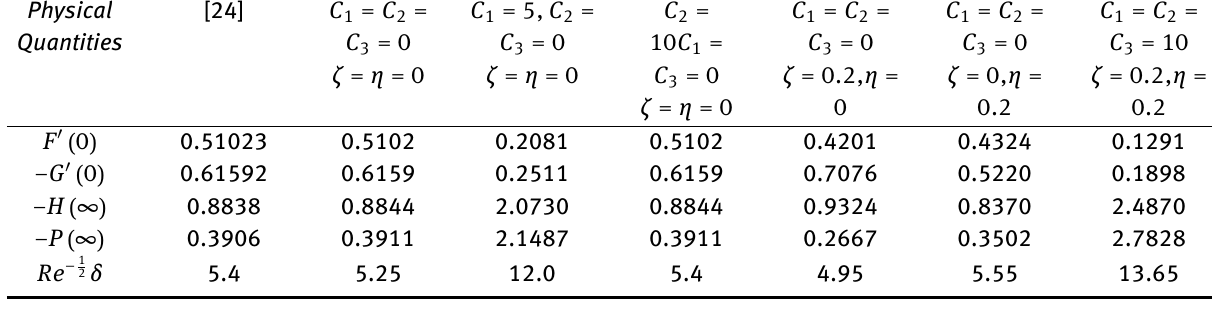
Table 2: Numerical comparison of some physical quantities with Ref. [24] obtained at Re = 2950 Physical Quantities